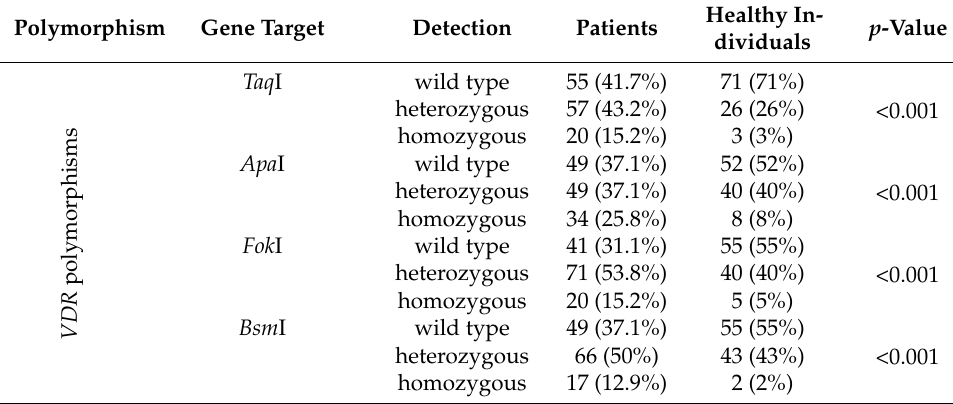
Table 3. Association of Toll-like receptors ( TLRs ) and vitamin D receptors ( VDR ) between CRC patients and healthy